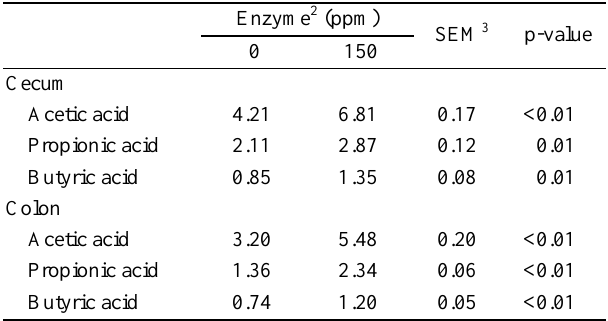
Table 4. Effect of enzyme supplementation on volatile fatty acid concentrations (mg/g of digesta) in the cecum and colon of weaned pigs 1